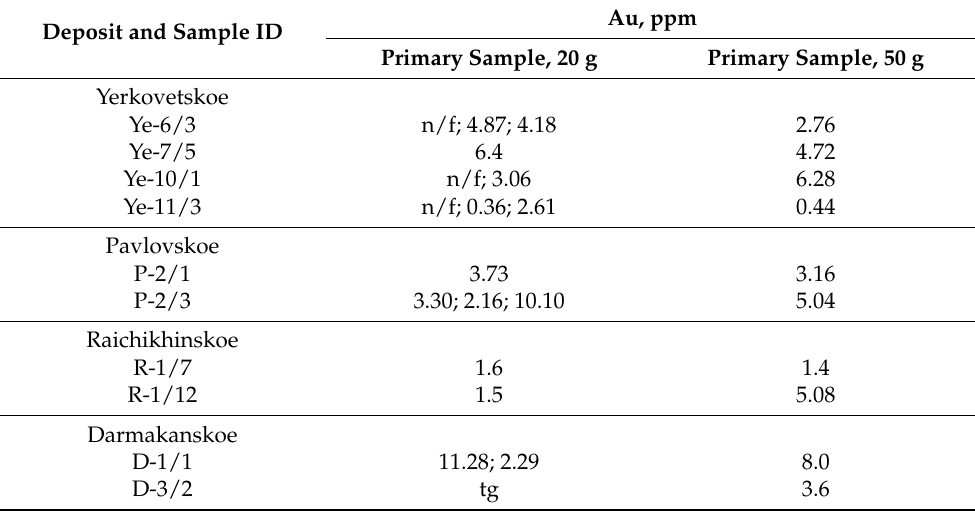
Table 1. Gold contents in coal samples of different weights based on assay